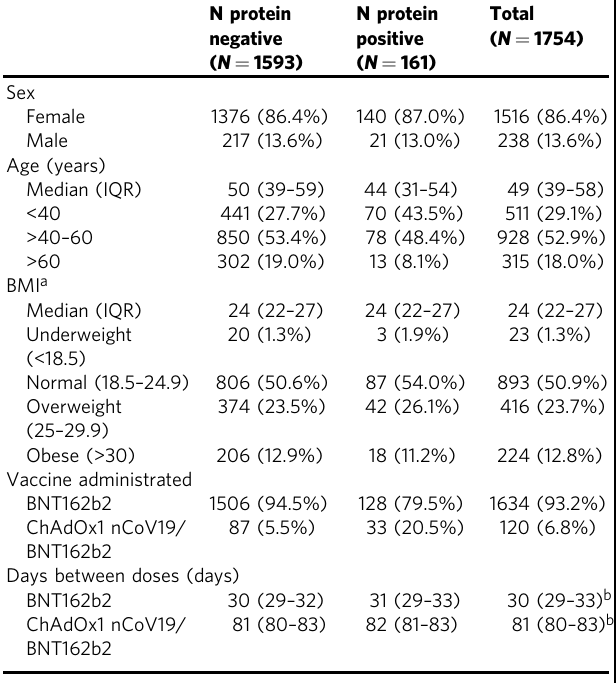
Table 1 Demographic data and characteristics from